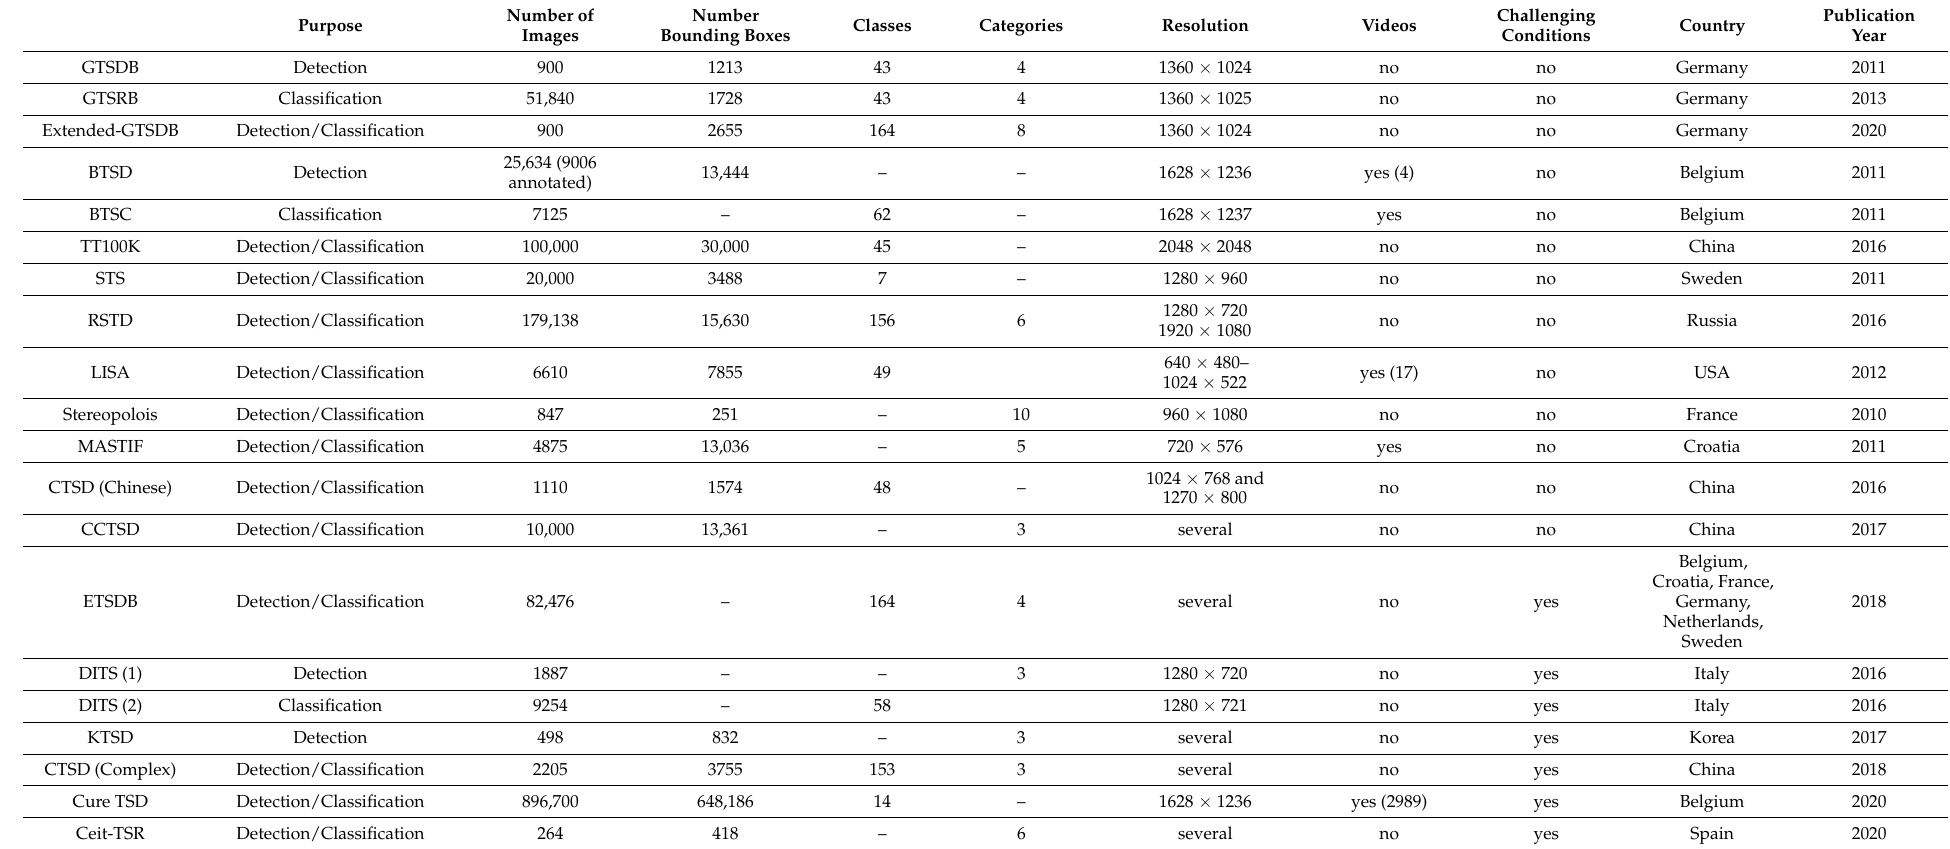
Table 1. Summary of the existing databases for traffic sign recognition (TSR) and its principal characteristics. It is also included our database